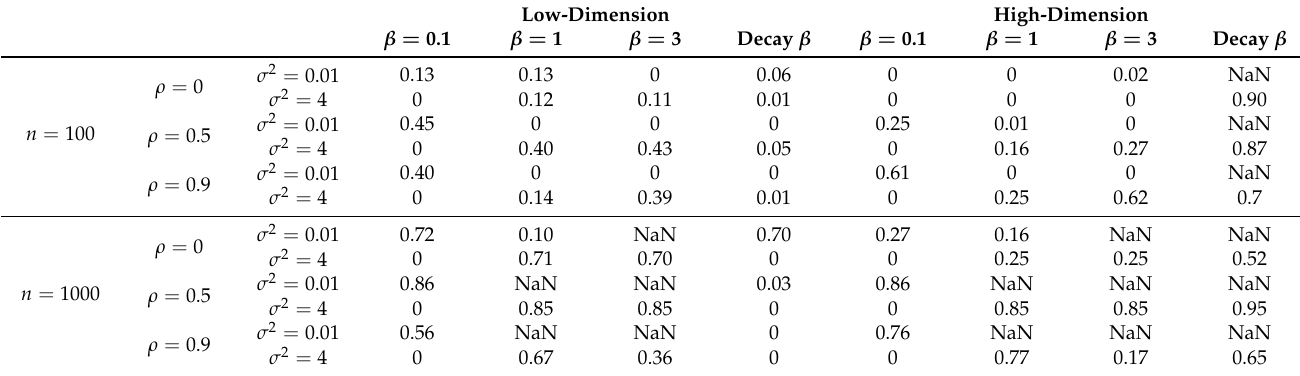
Table A7. Variable selection: P c ( λ 1 se ) − P c ( λ min ) , AR(1) correlation. Low-Dimension